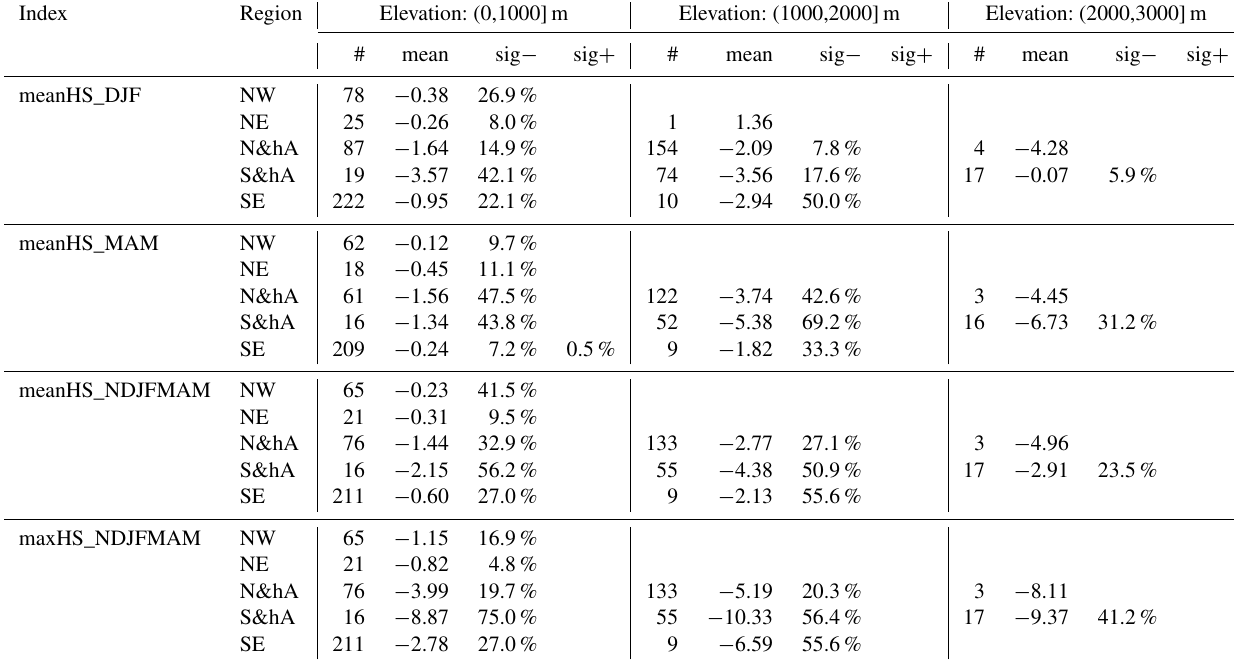
Table C1. Overview of long-term (1971 to 2019) trends in mean seasonal snow depth indices. Summaries are shown by index, region, and 1000m elevation bands (0 to 1000, 1000 to 2000, and 2000 to 3000m). Cell values are the number of stations (#), the mean trend (mean, in cm per decade), and percentages of significant negative (sig − ) and positive (sig + ) trends; the remaining percentage (not shown) corresponds to the total of non-significant negative and positive trends. Empty cells denote no station available (for # and mean) and no stations with significant negative or positive trends (sig − and sig + ) . Trends were considered significant if p < 0.05. See also Fig. C1. A version of the table with 500m bands instead of 1000m is available in the Supplement (Table S6).